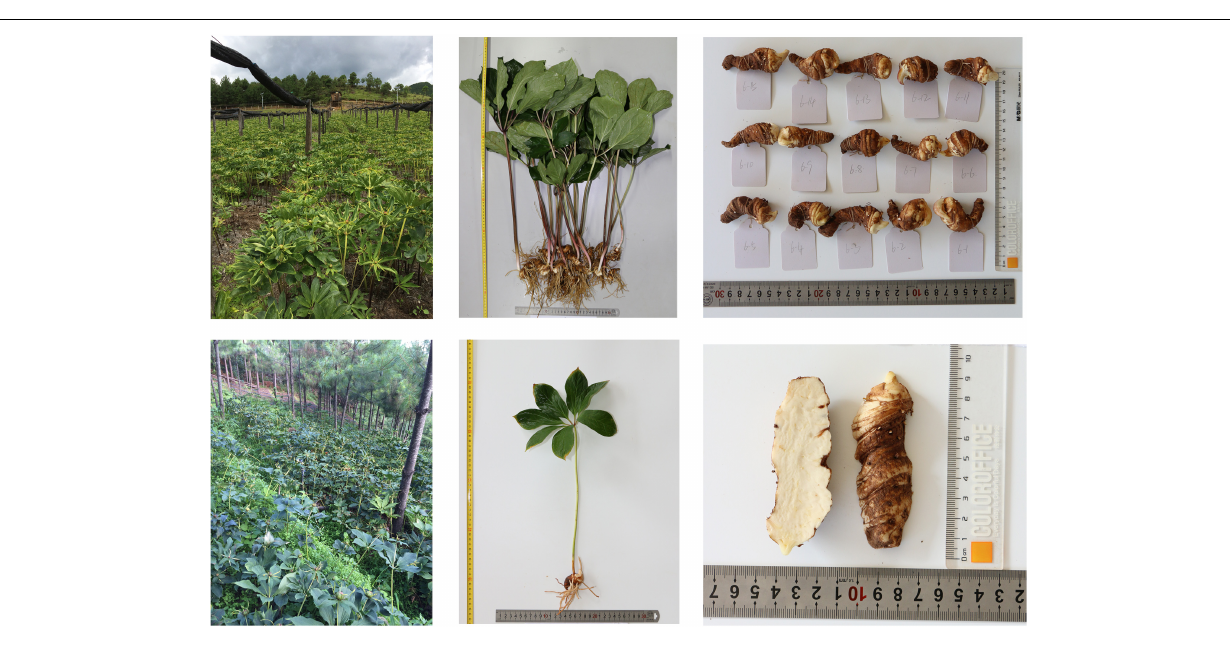
FIGURE 2 | Sample picture of the planting site, whole plant and rhizome of Paris polyphylla var.